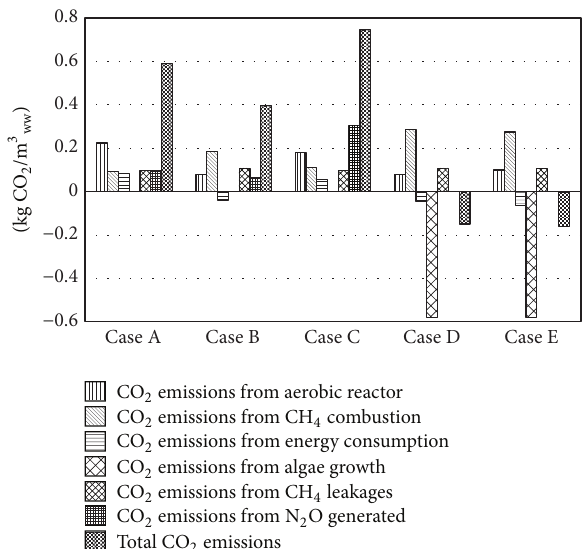
Figure 5: GHG emissions (expressed as kg CO 2 , equivalent/m 3 of wastewater treated) of different WWTPs